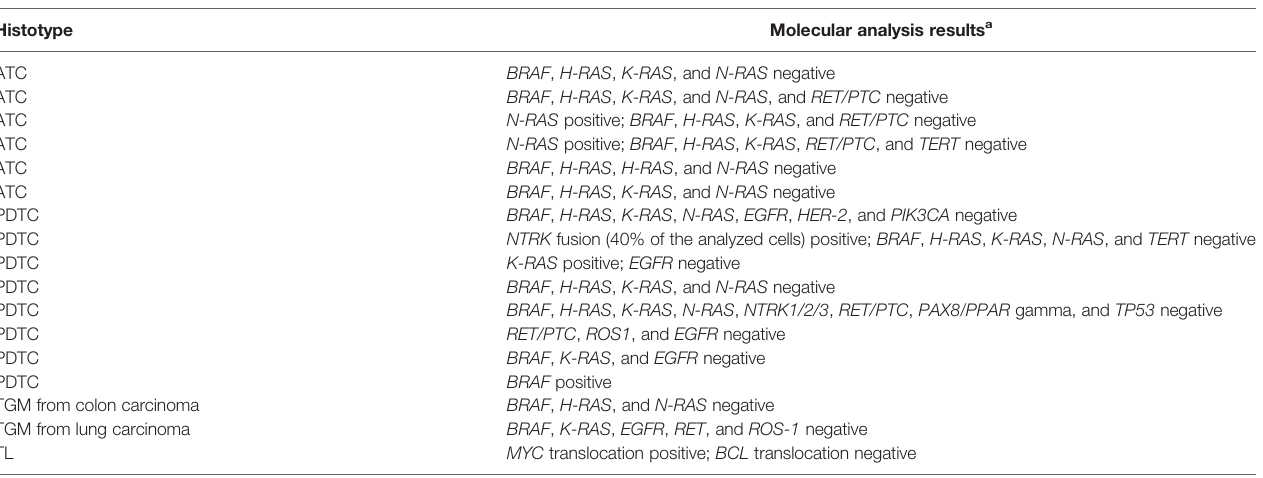
TABLE 3 | Results of the molecular analysis of 17